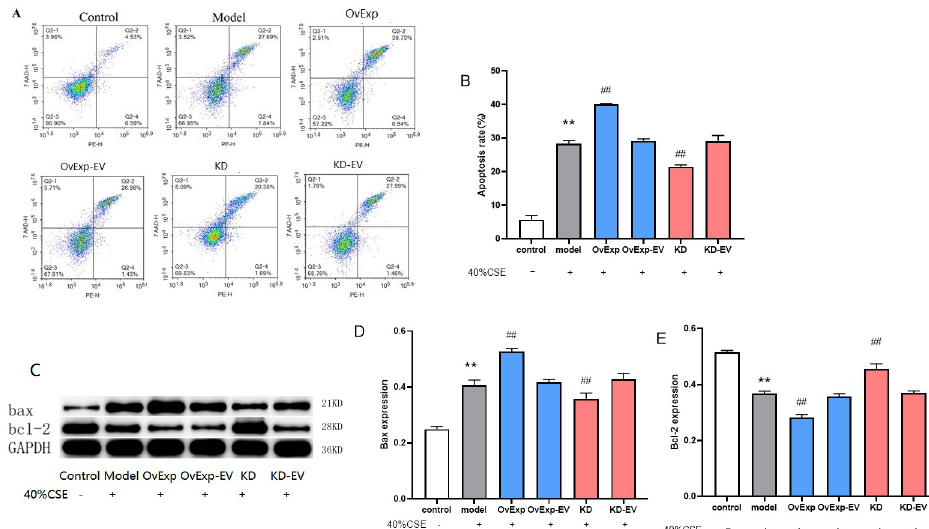
Fig 3. The apoptosis rate and apoptosis-related protein expression levels. The apoptosis rate was detected by flow cytometry. The increased apoptosis rate was observed in model group, which was reduced after IL-1 β knockdown (A, B). The expression level of Bax protein was higher in model group and vice versa for Bcl-2, which were revered considerably by IL-1 β knockdown (C-E). Results are represented as Mean ± S.E.M. �� P < 0.01 vs control; ## P < 0.01 vs model (n = 5).OvExp: overexpression; OvExp-EV: overexpression empty vectors; KD: knockdown; KD-EV: knockdown empty vector.